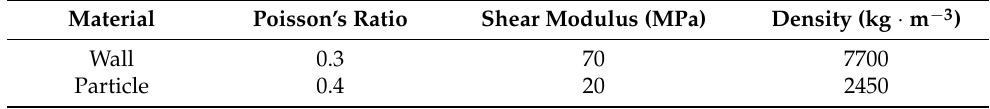
Table 2. Material parameters.